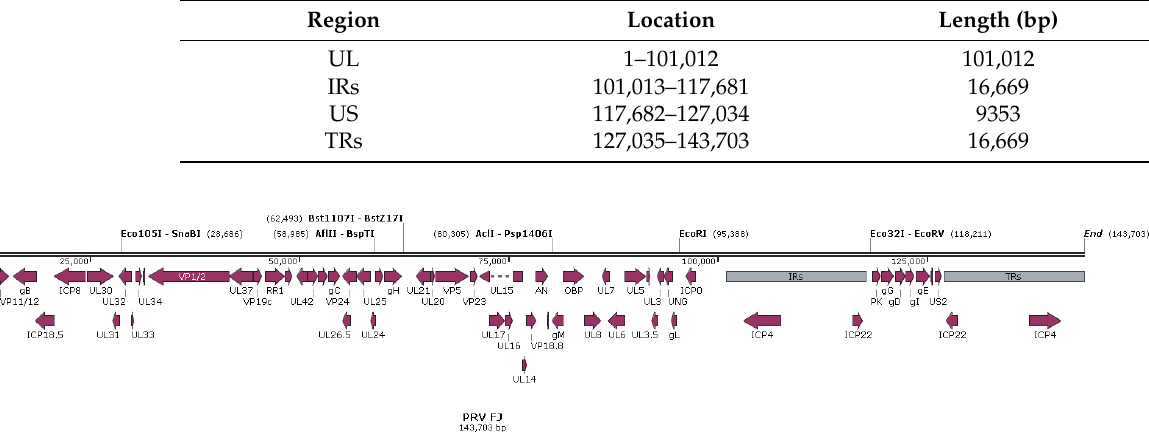
Figure 1. Sequences and distribution of the PRV FJ complete genome. Table 3. Annotation of each open reading frame of from the PRV FJ complete genome.